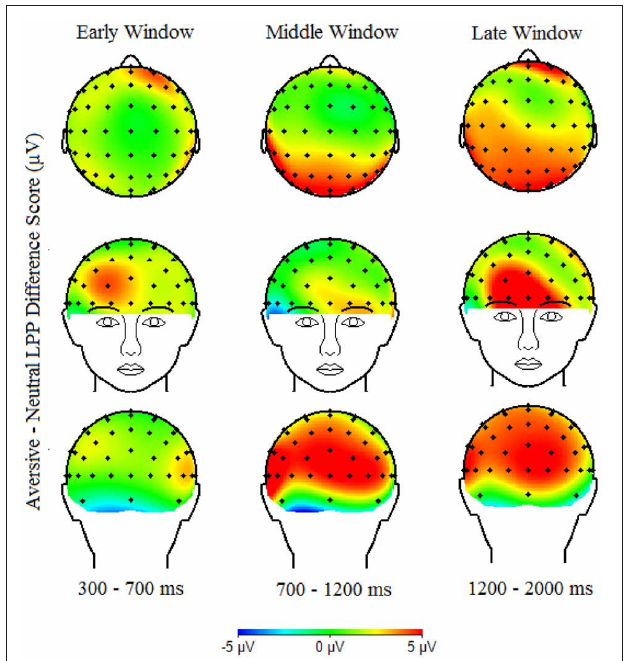
FIGURE 1 | Scalp topography of the LPP Aversive—Neutral difference score in the early (300–700ms), middle (700–1200ms) and late (1200–2000ms) time windows.